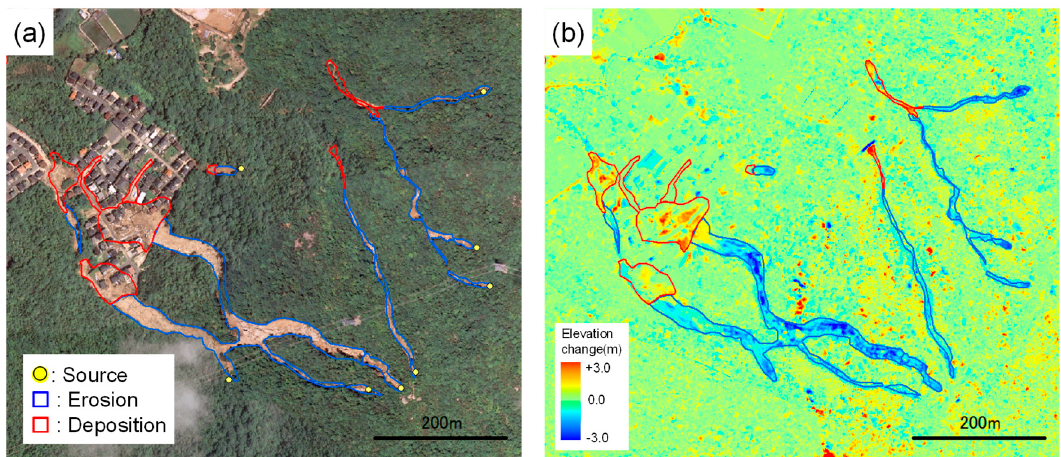
Figure 5. ( a ) Visually delineated erosion and deposition areas in debris flows in Kumano town. Background aerial photograph was observed after the event. ( b ) Elevation change (after-before) of LiDAR-derived DEMs.